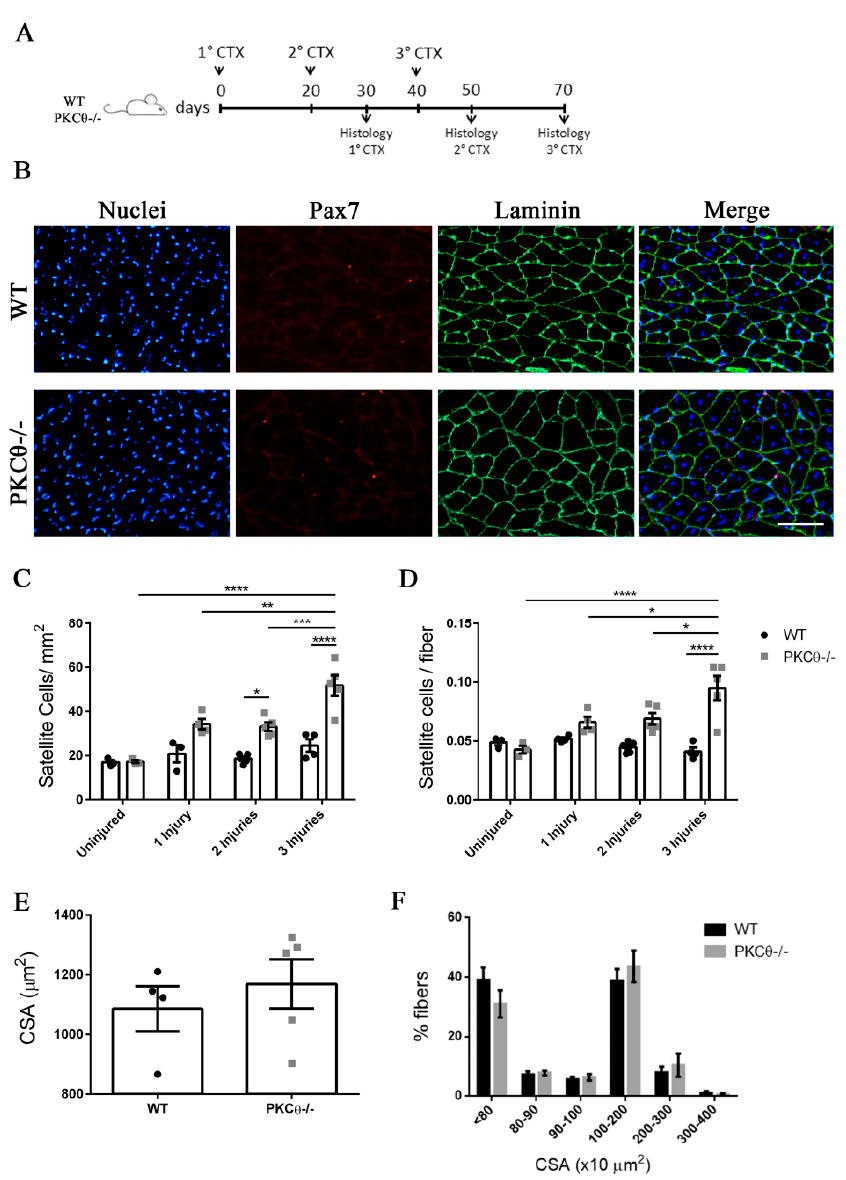
Figure 6. The number of quiescent satellite cells increases in PKC θ - / - mice after repeated injuries. ( A ): Experimental plan. ( B ): representative immunofluorescence pictures of WT and PKC θ - / - GA sections 30 days after 3 CTX injury, scale bar: 100 µ m. Sections were stained for Pax7 (red) and Laminin (green). Nuclei were counterstained with Hoechst. ( C ): Quantification of the number of SCs / mm 2 ( D ): and number of SCs per fiber in uninjured GA from WT and PKC θ - / - mice, or after 1, 2 and 3 injuries. ( E ): mean CSA of regenerated fibers 30 days after the third injury in WT and PKC θ - / - mice. ( F ): Frequency of myofiber CSA from GA muscles of WT and PKC θ - / - mice, 30 days after the third injury. Error bars represent mean ± sem, * p < 0.05, ** p < 0.01, *** p < 0.001, **** p < 0.0001 calculated by two-way ANOVA with adjustment for multiple comparison